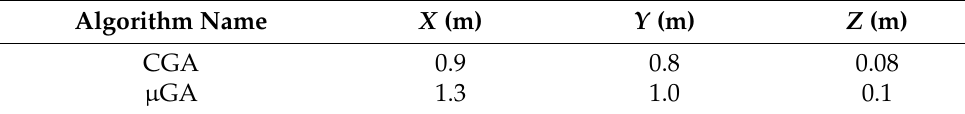
Table 8. Finding the alignment of the maximum